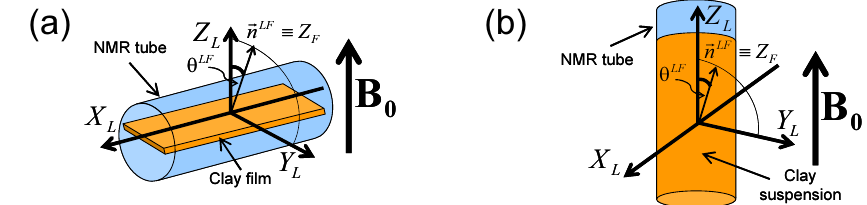
Figure 3. Schematic view of: ( a ) the clay film within the NMR tube inserted into the detection coil (see text) and ( b ) the clay suspensions into the NMR tube. The X L and Z L directors are parallel to the axes of the NMR detection coil and the static magnetic field B 0 respectively. The θ LF Euler angle and the director (cid:126) n LF characterise the orientation of the clay sample by reference to the static magnetic field B 0 . Reprinted with permission from [23]. Copyright (2014) American Chemical